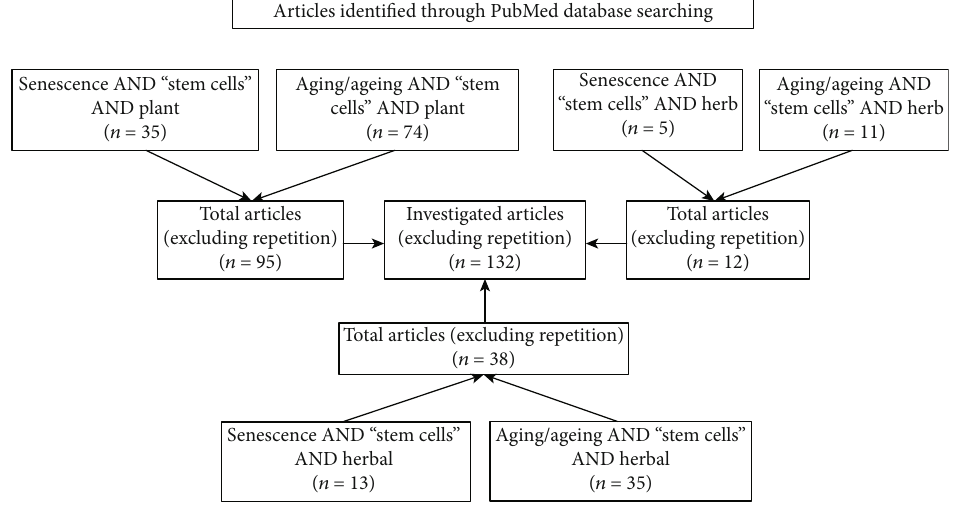
Figure 2: Flow diagram of PubMed data